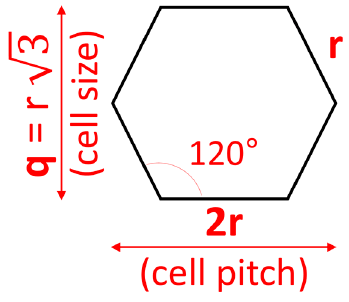
Figure 6. Honeycomb cell parameters in Equation (8).